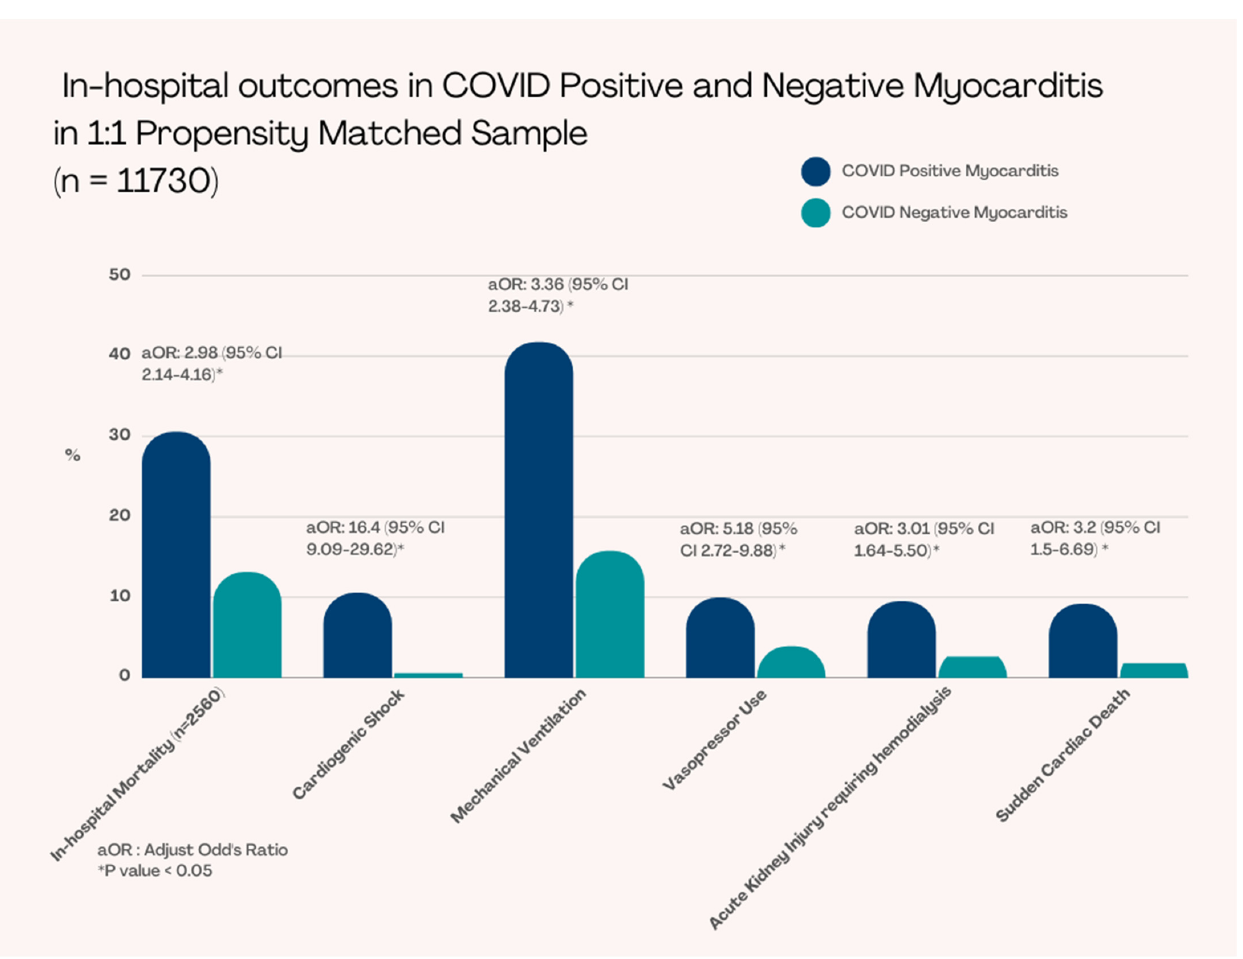
Figure 2. In-hospital Outcomes in COVID-19 Positive and Negative Myocarditis in 1:1 Propensity Matched Sample. Table 3. In-hospital Outcomes for 1:1 PS Matched Sample.